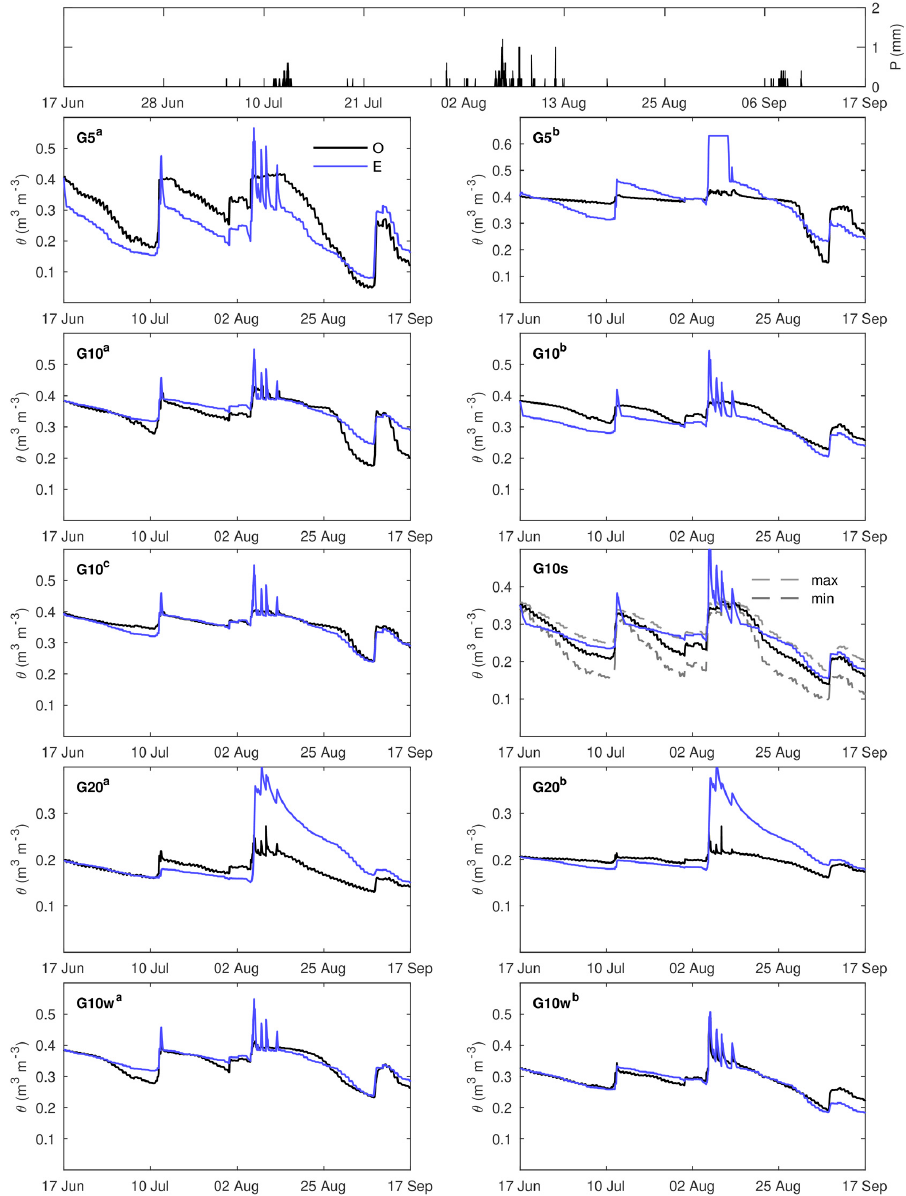
Figure 4. Observed (O) (black lines) and estimated (E) (blue lines) substrate moisture during the rainy season 2015. The precipitation hyetograph is also presented.